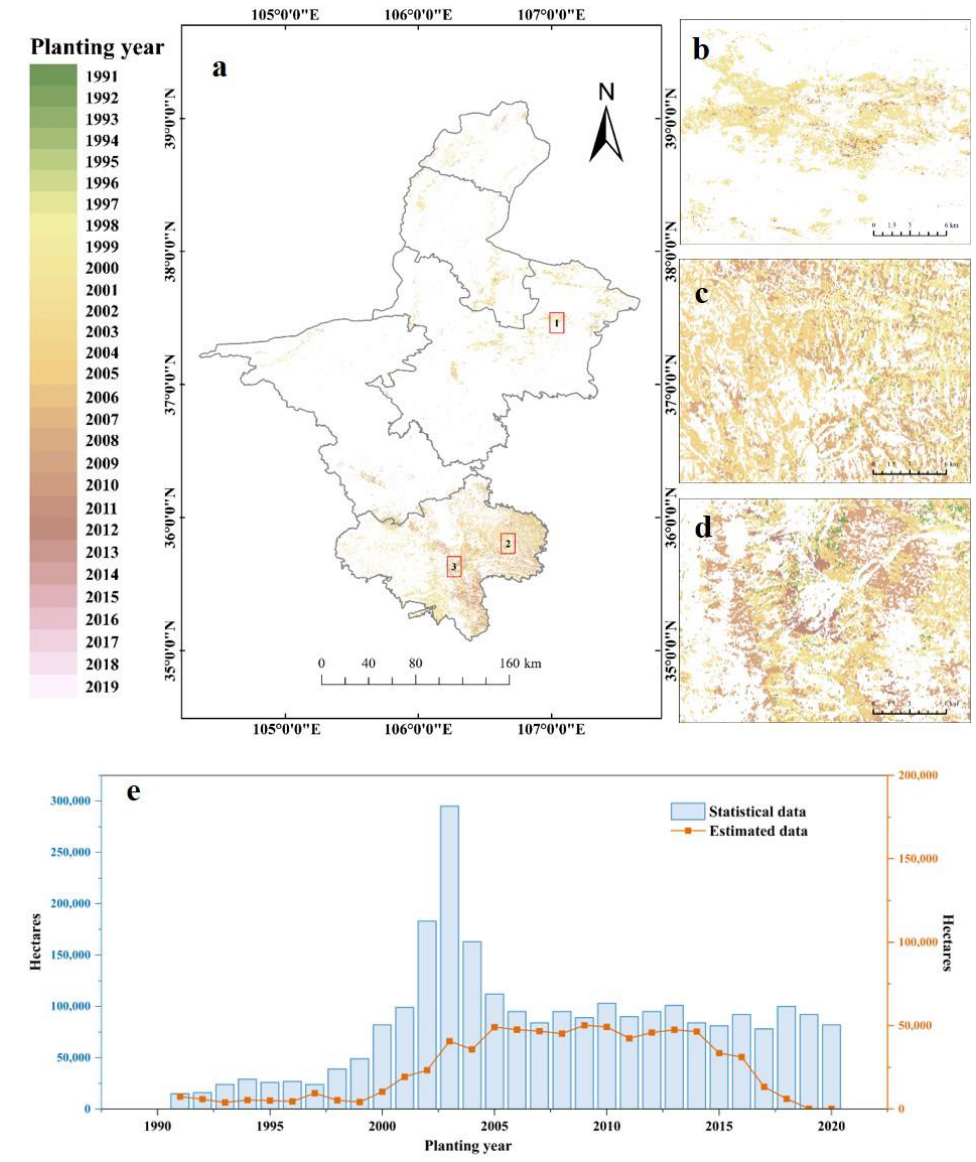
Figure 10. ( a ) The 2020 NHAR planting year map. ( b – d ) Enlarged maps of the three regions labeled as 1, 2, and 3 in ( a ). ( e ) Statistical data of the afforestation area for each year from official statistics (blue bars), and estimated data of the annual planting area derived from the planting year map (orange broken line).